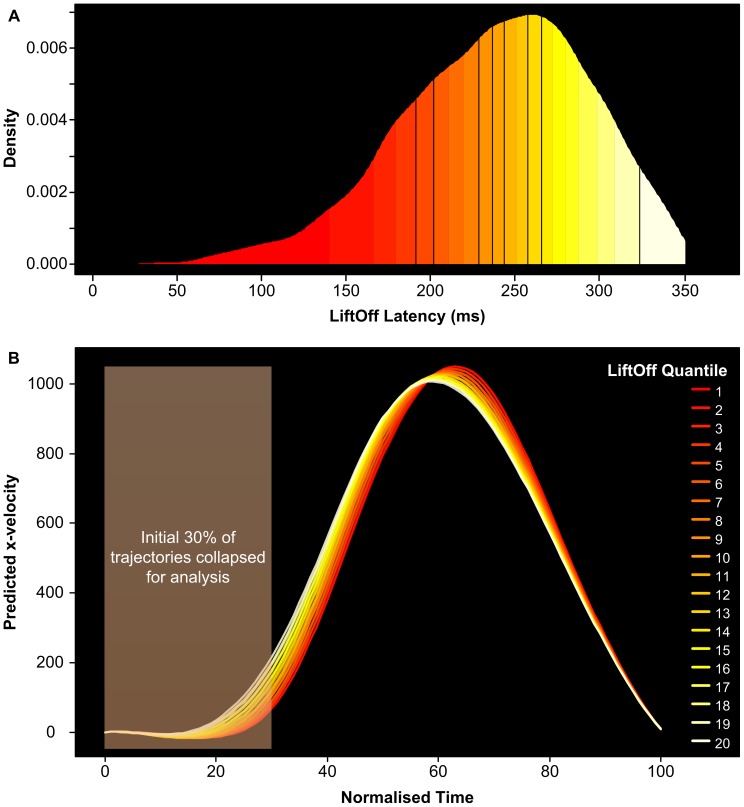
Grouping trajectories by Target-Viewing Time.(A) Analysis begins with the distribution of LiftOff Latencies (i.e. Target-Viewing times), estimated relative to target onset. A modified version of OPTA is used to fit a polynomial regression model to the x-velocity profile for each trial. The model includes LiftOff Latency percentile as a covariate (see text). (B) Predicted x-velocity profiles are grouped into semi-decile intervals. Red colours indicate trials with short LiftOff Latencies (beginning at the 1st semi-decile); white-colours correspond to longest LiftOff Latencies (20th semi-decile). Note the clear effect of LiftOff Latency: the longer subjects wait to begin moving, the faster the finger moves in the correct direction.